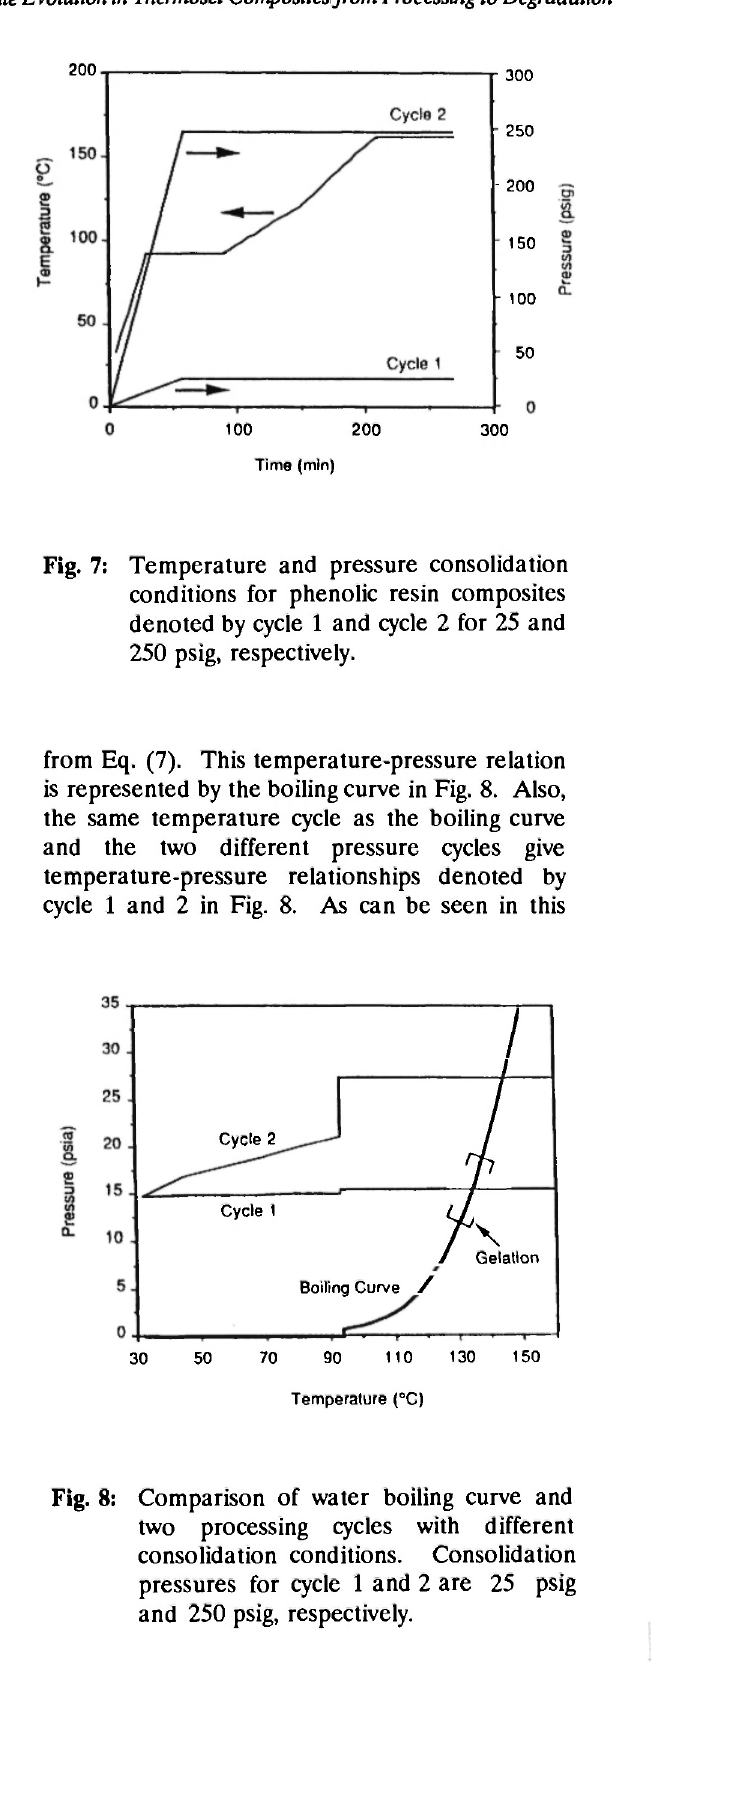
Fig. 8: Comparison of water boiling curve and two processing cycles with different consolidation conditions. Consolidation pressures for cycle 1 and 2 are 25 psig and 250 psig,